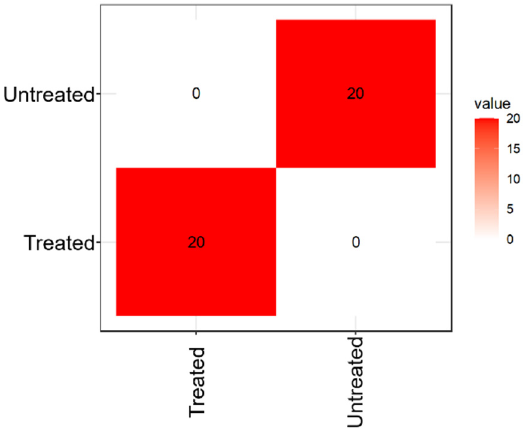
Figure 2. Confusion matrix for the water quality parameters in a Random Forest classifier between Treated and Untreated biotreated hospital wastewater.